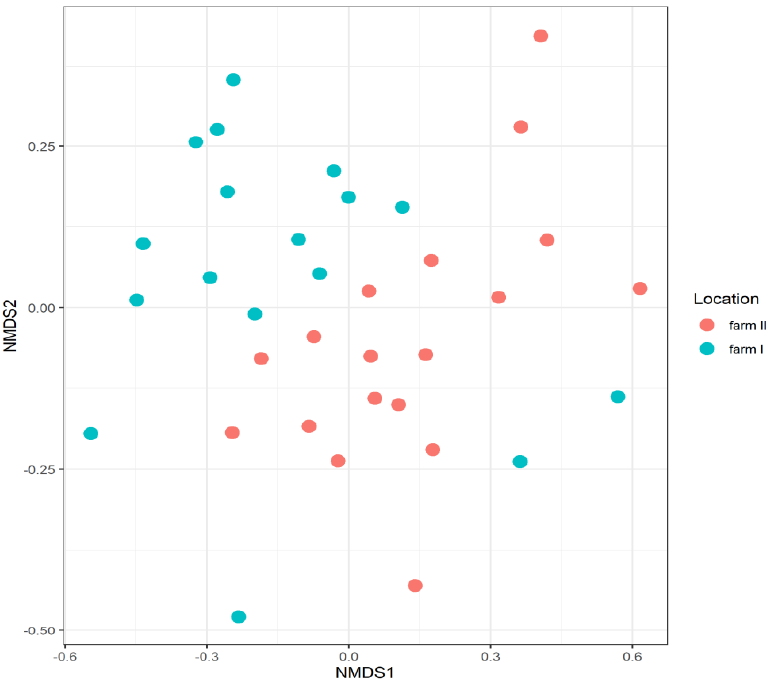
Figure 7. NMDS plot of beta-diversity showing the effect of location (farm) on the faecal microbiota composition of 35 horses. Red = Farm II, Blue = Farm I. NMDS stress level = 0.17.